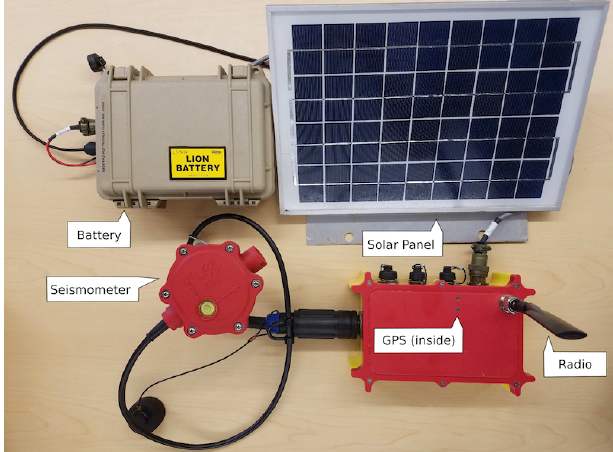
Figure 3. SAMERA hardware platform prototype. It has a geophone, global positioning system (GPS), computing board, wireless radio, solar panel, and